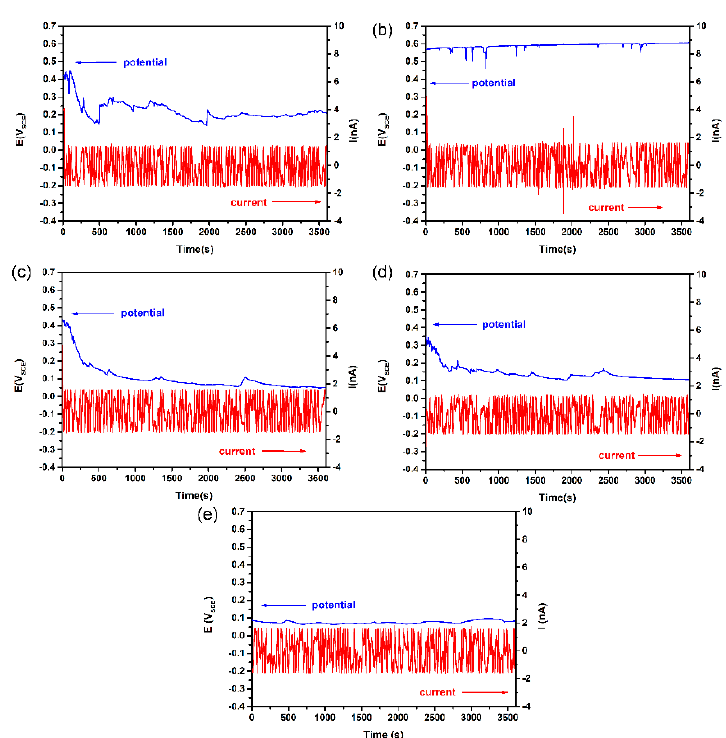
Figure 2. Typical EN patterns of DSS 2205 of different surface roughness conditions in 10% FeCl 3 solution at 50 °C: ( a ) 180#; ( b ) 600#; ( c ) 1000#; ( d ) 2000#; € polished.